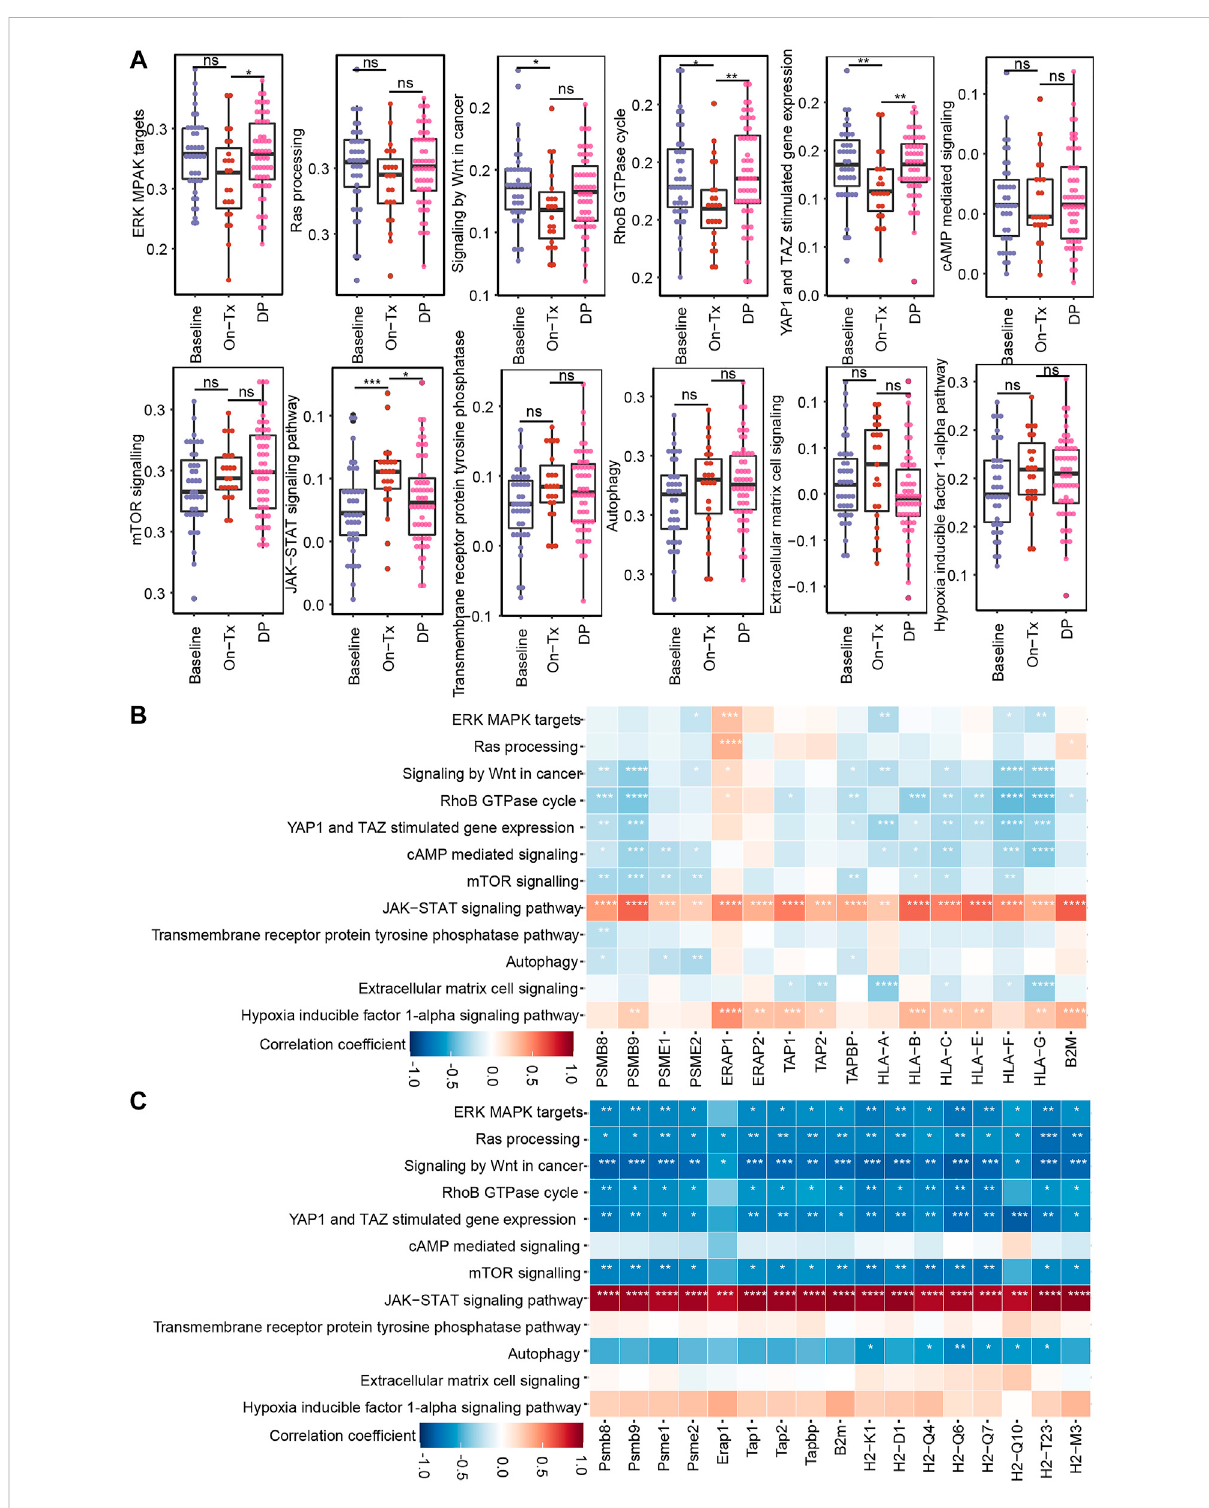
FIGURE 7 Correlation between MHC-I molecules and MAPK-targeted therapy resistance-related pathways. (A) Boxplot shows the activation levels of MAPKi resistance-related signaling pathways in clinical samples at different stages of targeted therapy (GSE75313, GSE65185, and EGAS00001000992). Statistical analysis was performed using the Wilcoxon test. ns p > 0.05; p p < 0.05; pp p < 0.01; ppp p < 0.001; pppp p < 0.0001. (B) Heatmap showing Pearson ’ s correlations between MHC-I molecules and MAPKi resistance-related pathways in melanoma biopsy